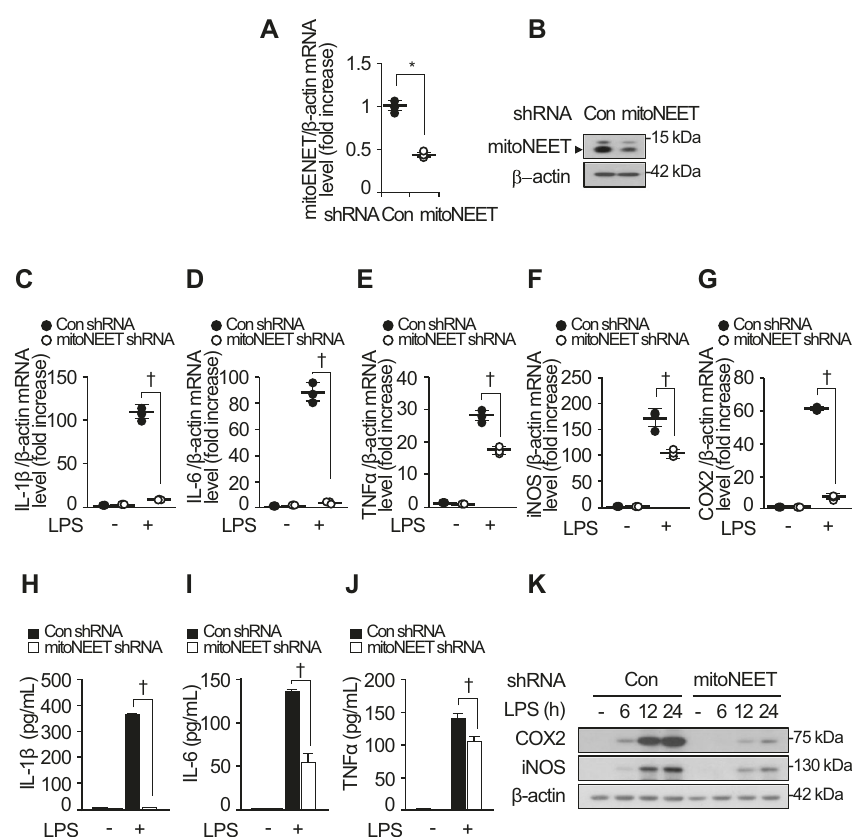
Fig. 3 Expression of mitoNEET shRNA decreases the levels of in fl ammatory mediators produced by RAW264.7 cells. RAW264.7 cells were transfected with control shRNA or mitoNEET shRNA and then subjected to RT-PCR or western blotting to verify downregulation of mitoNEET expression ( A and B ). β -actin was used as a loading control. RAW264.7 cells transfected with control shRNA or mitoNEET shRNA were stimulated with LPS (100 ng/mL) or vehicle. Total RNA, cell supernatants, and total protein were harvested 12 h (for mRNA) or 24 h (for protein) later. Expression of mRNA encoding IL-1 β , IL-6, TNF α , iNOS, and COX2 was assessed by quantitative real-time RT-PCR ( C – G ), and protein expression was analyzed by ELISA or western blotting ( H – K ). All data are expressed as the mean ± SD from three independent experiments. *P < 0.05 for control shRNA-expressing cells vs. mitoNEET shRNA-expressing cells. † P < 0.05 for control shRNA-expressing cells vs. mitoNEET shRNA-expressing cells in the presence of demonstrated that NL-1 or mitoNEET shRNA suppressed LPS- induced cytosolic ROS when compared with LPS alone (Fig. 5E, F). Treatment of cells with the iron chelator DFO (deferoxamine) in the presence of LPS showed results comparable to those observed after mitoNEET inhibition by NL-1 or mitoNEET shRNA (Fig. 5E, F). To verify whether inhibition of mitoNEET regulates mitochondrial dysfunction, we examined the mitochondrial membrane potential (MMP), a hallmark of mitochondrial dysfunction. Cells were treated NL-1 in the presence or absence of LPS, and the loss of MMP was measured by fl ow cytometry using MitoProbe JC-1. Inhibition of mitoNEET rescued LPS-induced depolarization of the mitochon- drial membrane (Fig. 6A). LPS-induced loss of MMP was also rescued by mitoNEET shRNA (Fig. 6B). To verify the effects of NL-1 on the MMP, we stained LPS-stimulated RAW264.7 cells with mitochondrial probes MitoTracker Red CMXRos, DiOC6(3), or TMRM (tetramethylrhodamine, methyl ester) in the presence or